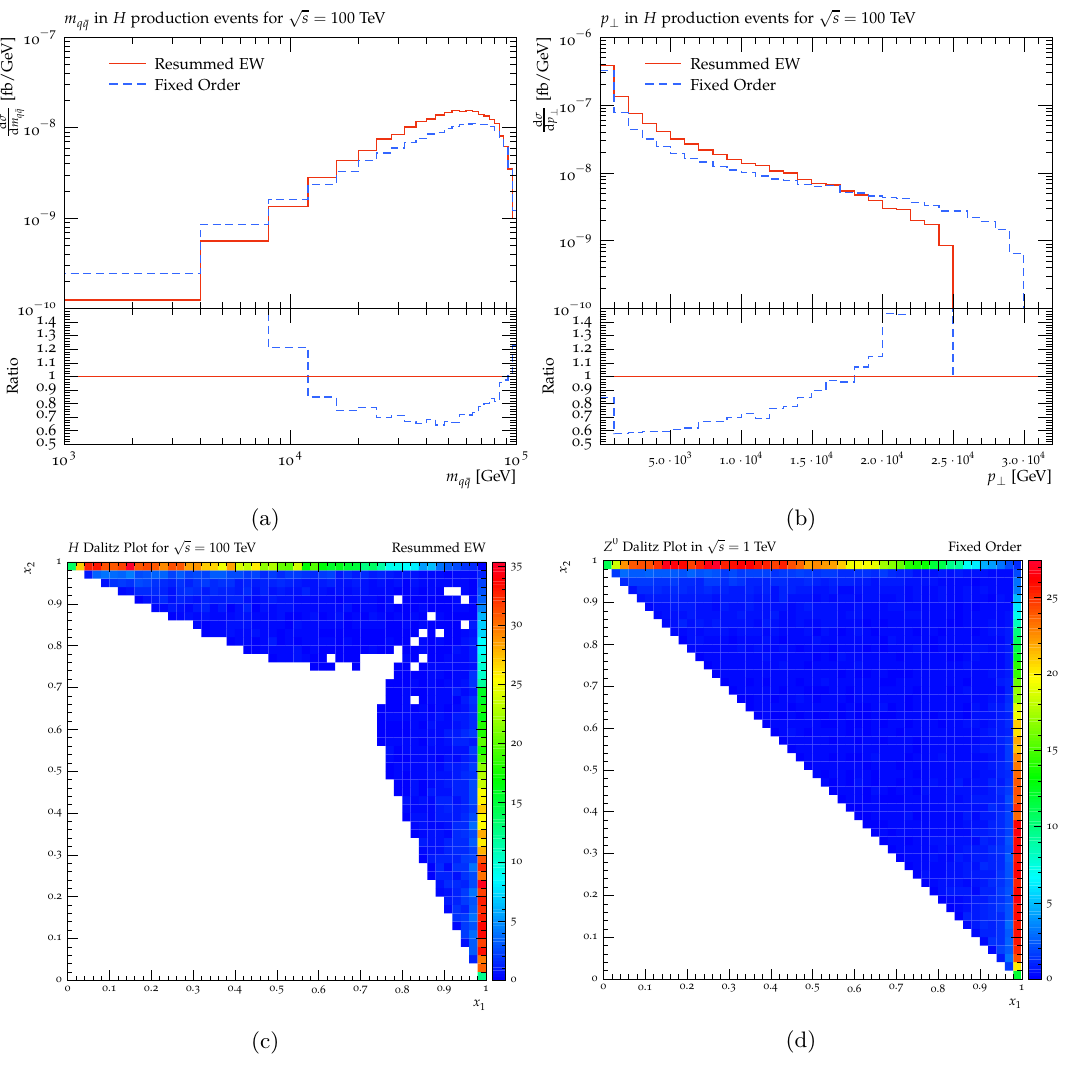
√ s = 10 TeV. The notation